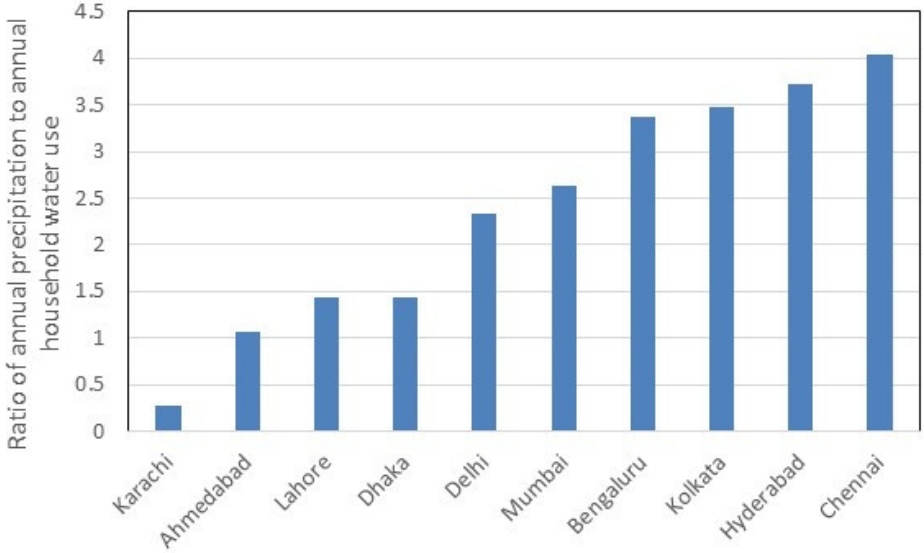
Figure 14. The total annual rainfall that falls within city boundaries is typically greater than the amount of water consumed by the city’s households. Graph shows the ratio of total annual precipitation to total annual household water use, for selected South Asian cities.